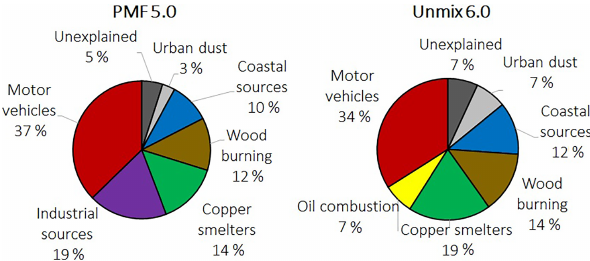
Figure 2. Source apportionment of fine particulate matter in San- tiago, Chile, over the whole period 1998–2012 using two different models. The PM 2 . 5 median over 15 years was 24.19µgm − 3